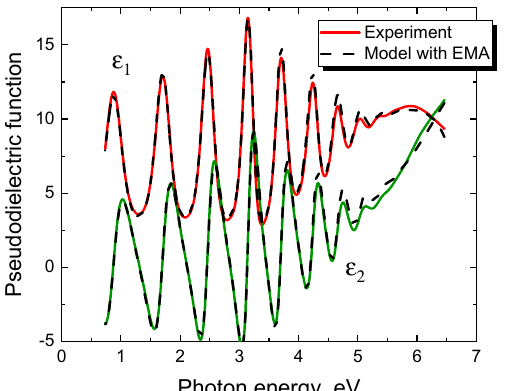
Figure 3. Dependence of the pseudodielectric function ( ε 1 is its real part, ε 2 is its imaginary part) on the photon energy of a SiC/Si(111) sample grown by the CVD method by Advanced Epi using patented technology (solid line). The dashed line is the same relationship calculated using the EMA model.